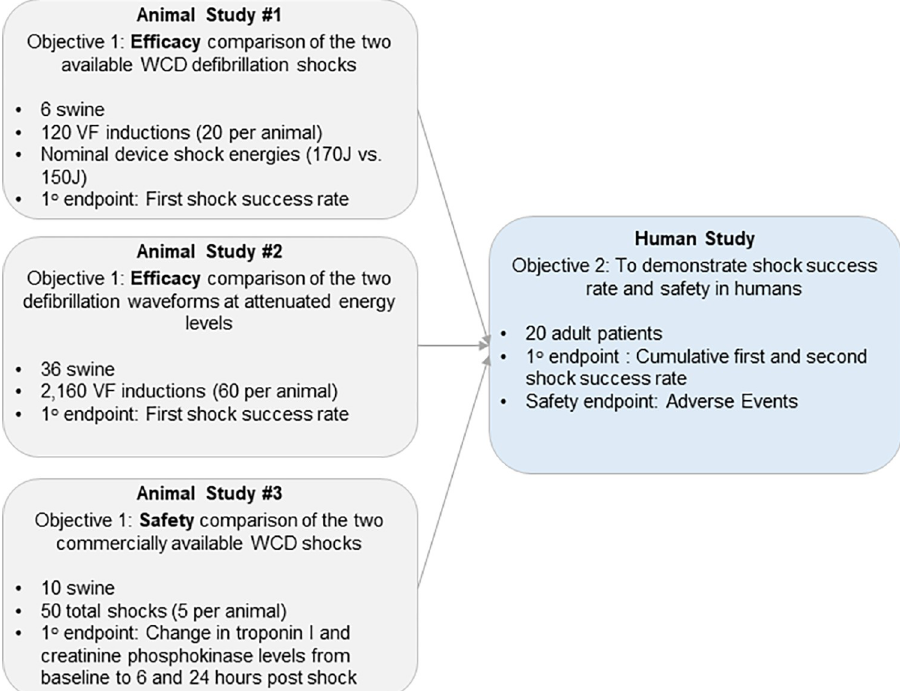
Fig 1. Flowchart of the defibrillation safety and efficacy studies. Flowchart describing objectives, endpoints and sample sizes for the three animal studies and one human study providing a comprehensive assessment of defibrillation safety and efficacy of the new BTE waveform designed for use in a